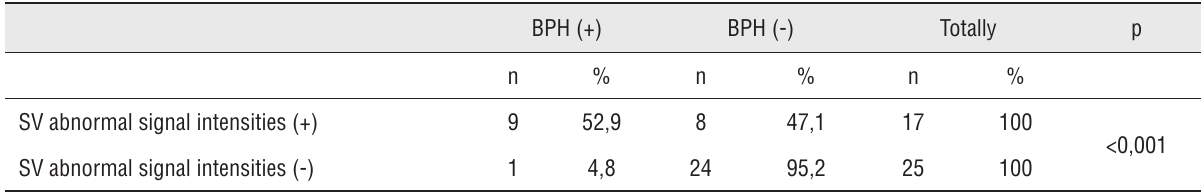
Table 5 - Association between sv abnormal signal intensity and BPh.